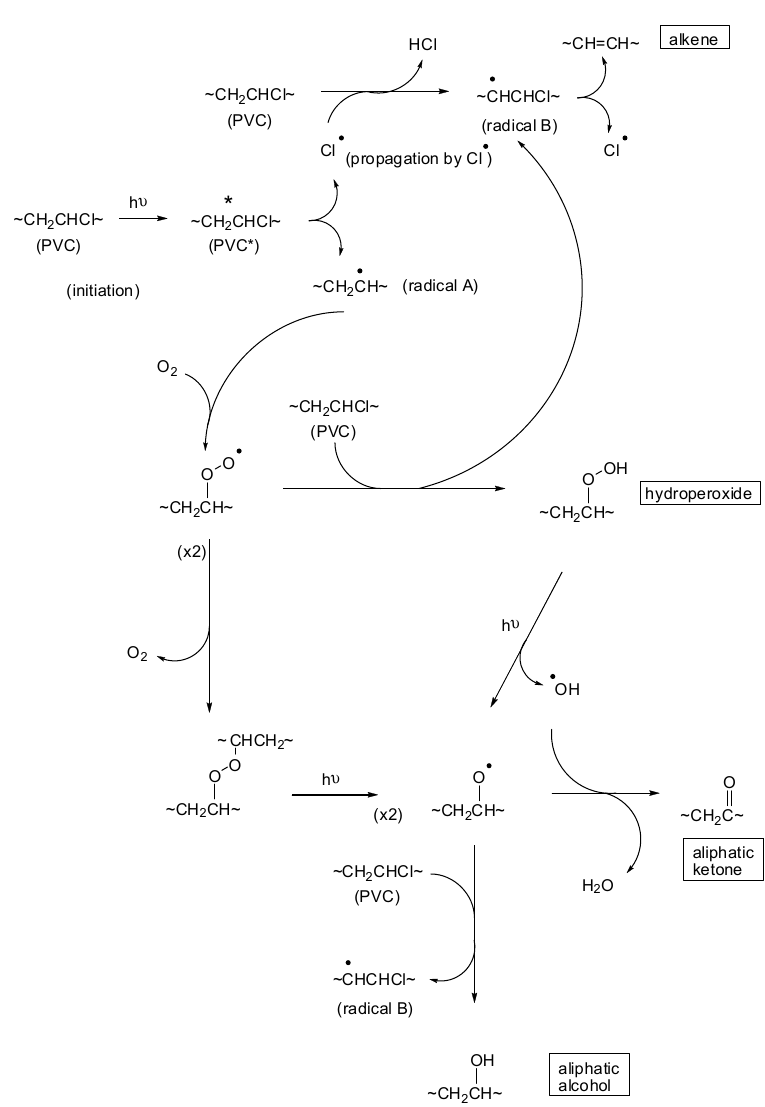
Scheme 1. Photo-oxidation reaction scheme of PVC [28]. Where “ * ” represent excited state and “•”represent free